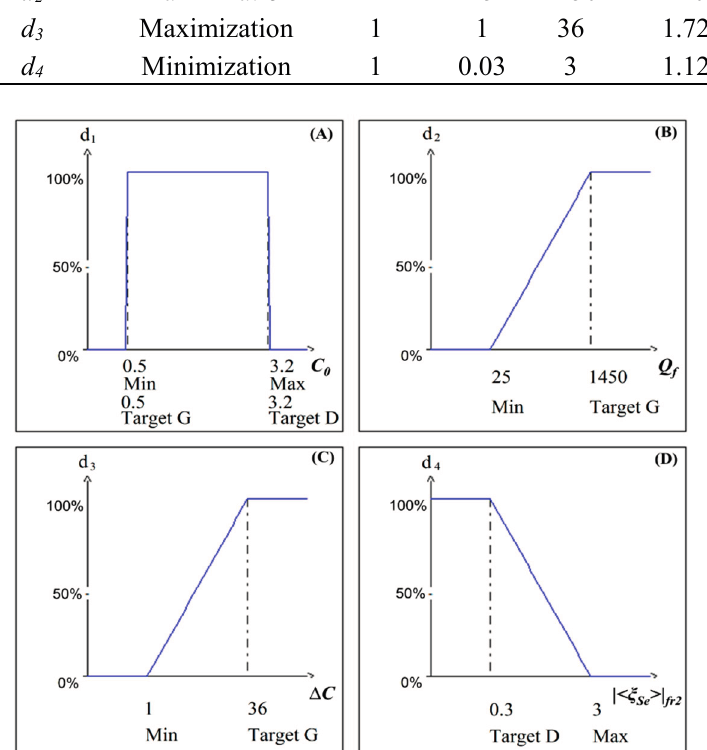
Figure 10. Desirability functions for multi-criteria optimization of acoustic resonant sensor (for ( A ) 0.5 ≤ (cid:1829) ≤ 3.2 pF; ( B ) (cid:1843) ≥ 25; ( C ) ∆(cid:1829) ≥ 1fF; ( D ) | ˂ξ Se ˃ | fr2 ≤ 3 (cid:2868) (cid:3033)